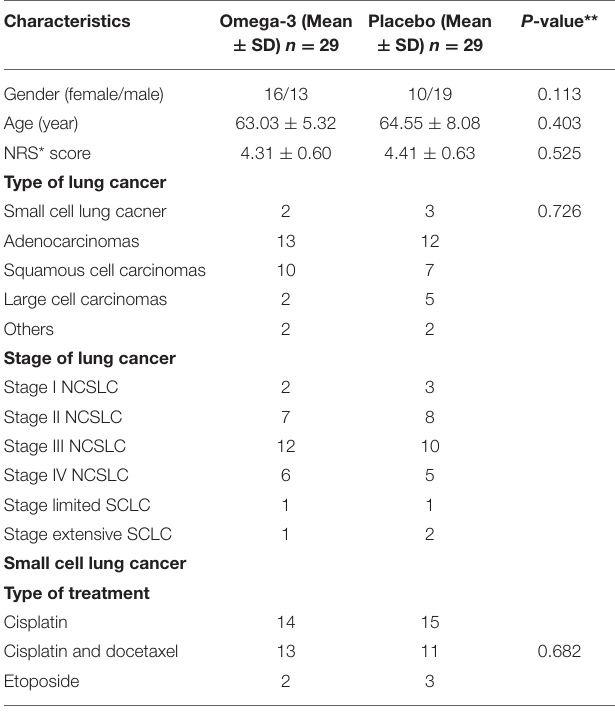
TABLE 1 | Baseline demographic and clinical characteristics of patients with lung cancer in omega-3 fatty acid supplementation and placebo groups. Characteristics